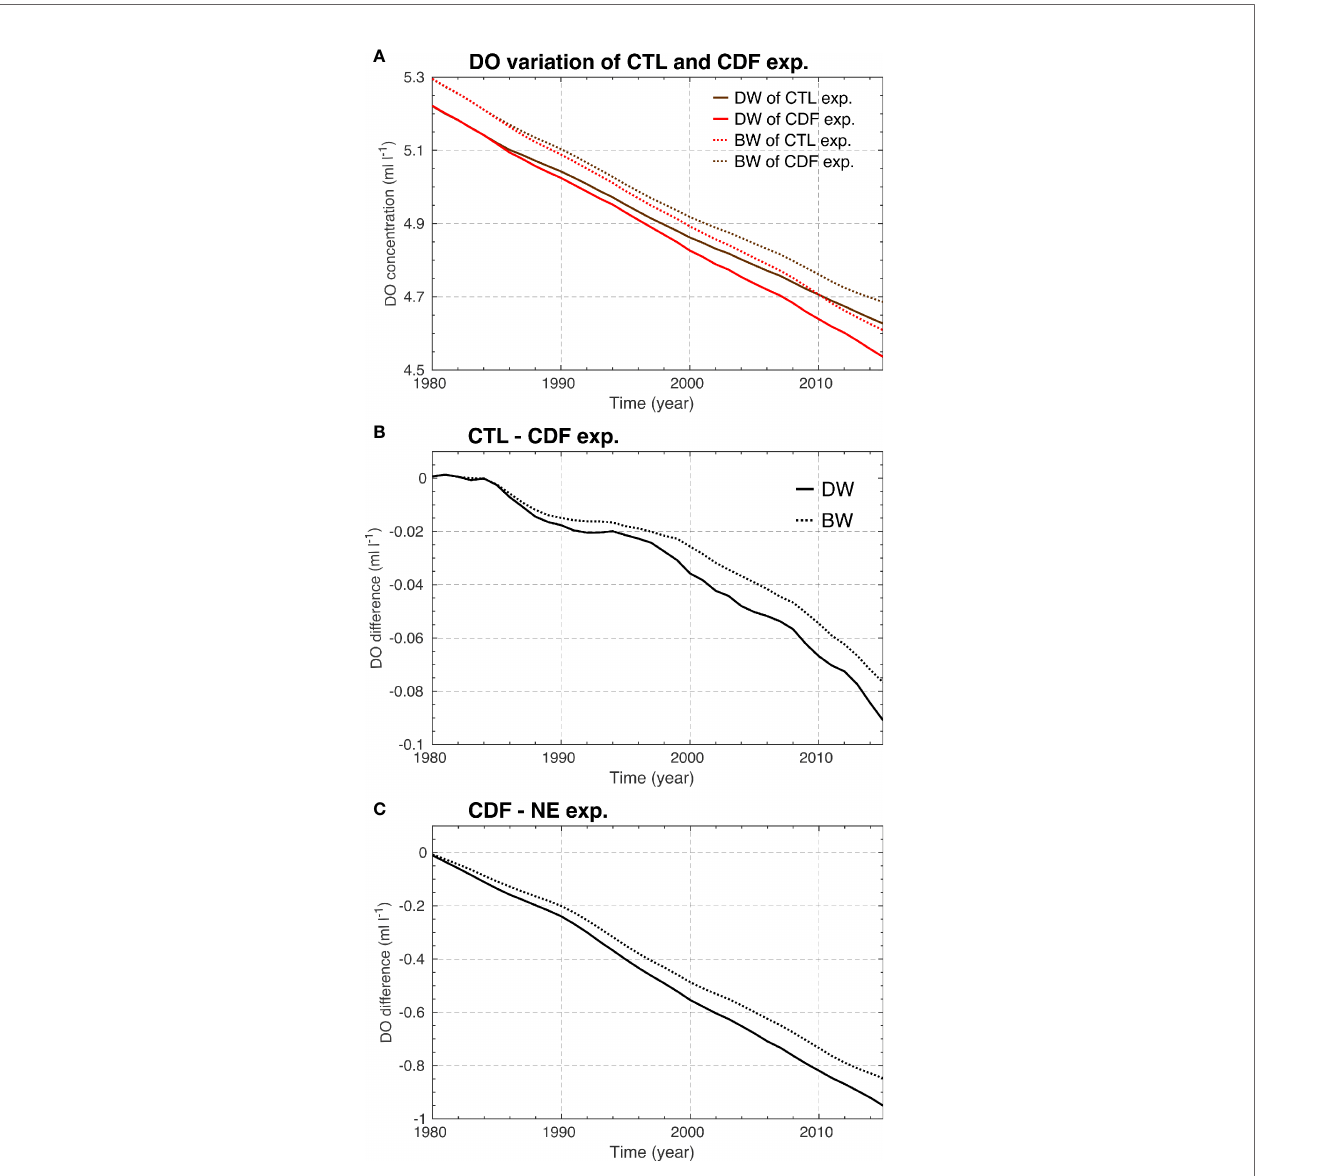
FIGURE 9 | (A) Long-term variation in the dissolved oxygen (DO) concentration of the constant detritus fl ux (CDF; brown) and the control (CTL; red) experiments. Difference in the DO concentration (B) between the CTL and the CDF experiment, (C) between the CDF and the no-ecosystem (NE) experiments. Solid and dotted lines indicate the DO concentration averaged in the East/Japan Sea from 1618 to 2250 m (deep water: DW) and 2250 m to the bottom (bottom water: BW),